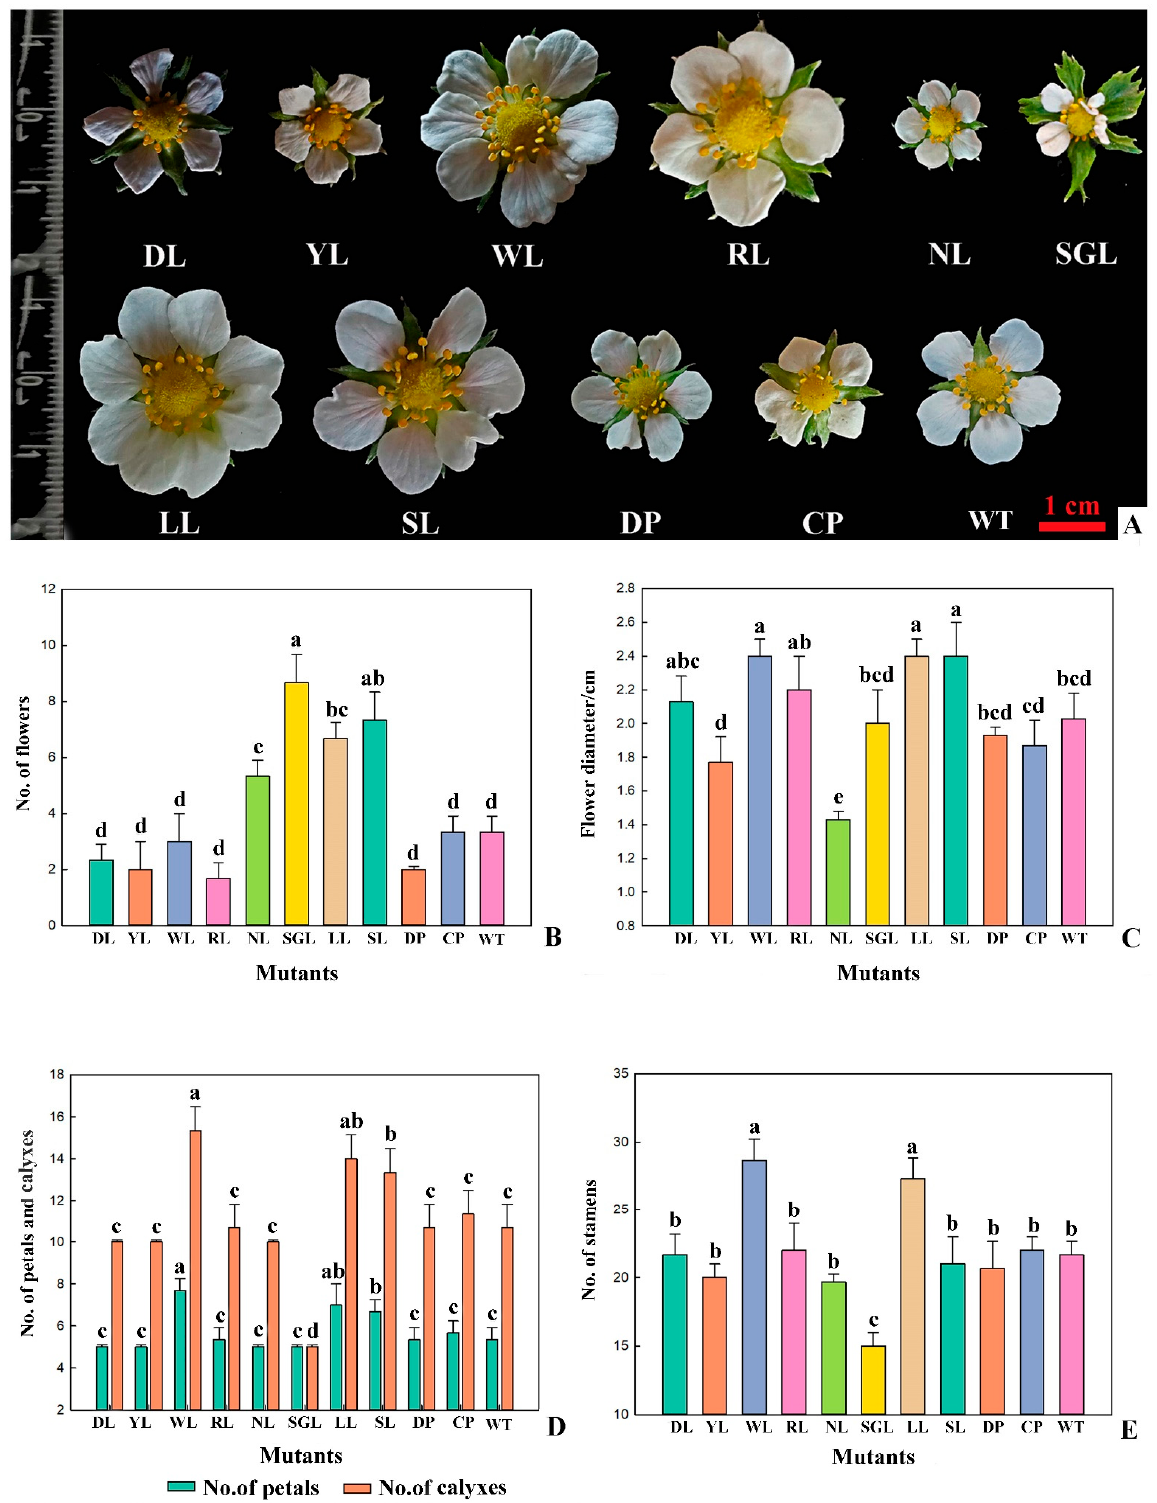
Figure 4. The flower traits of 10 mutants in F. nilgerrensis . ( A ) Flowers of 10 mutants; ( B ) No. of flowers; ( C ) flower diameter; ( D ) No. of petals and calyxes; ( E ) No. of stamens. Abbreviated letters of mutants were described in Figure 2. Bars indicate S.E. of means, and different lowercase letters indicate significant differences between treatments according to LSD test ( p < 0.05). Scale bar = 1